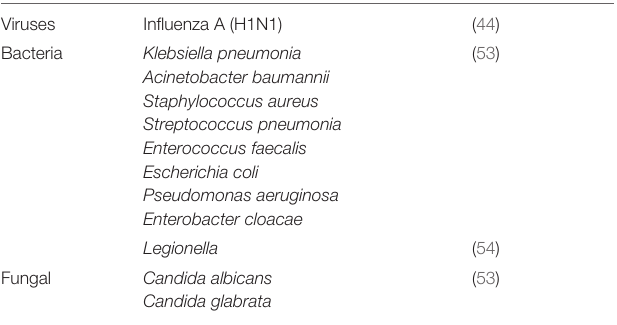
TABLE 3 | Reported coinfections with SARS-CoV-2 in Egypt.